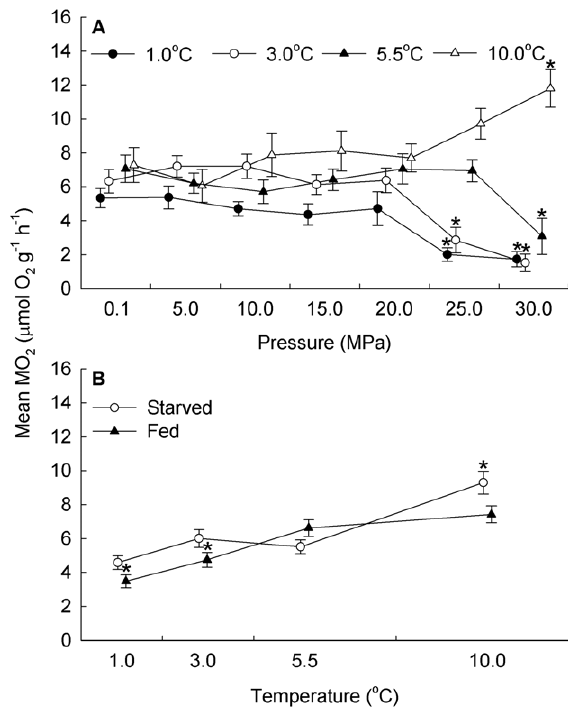
Figure 3. Starvation, temperature and pressure effects on the rate of oxygen consumption of Stephonyxbiscayensis . ( A ) Fed and starved treatments were pooled in the absence of a starvation effect on the interaction of temperature and pressure effects. Subsequently the effect of temperature on the relationship between pressure and mean ( 6 1 s.e.) rate of oxygen consumption (MO 2 ) of Stephonyx biscayensis acclimated to atmospheric pressure is shown (10 individuals per data point). ( B ) Similarly, pressure treatments were pooled in the absence of a pressure effect on the interaction of starvation and temperature effects. Subsequently the effect of starvation on the relationship between temperature and mean ( 6 1 s.e.) MO 2 of Stephonyx biscayensis acclimated to atmospheric pressure is shown (35 individuals per data point). Treatments are offset for clarity and those differing significantly from 0.1 MPa ( A ) or 5.5 u C ( B ) are indicated by an asterisk.